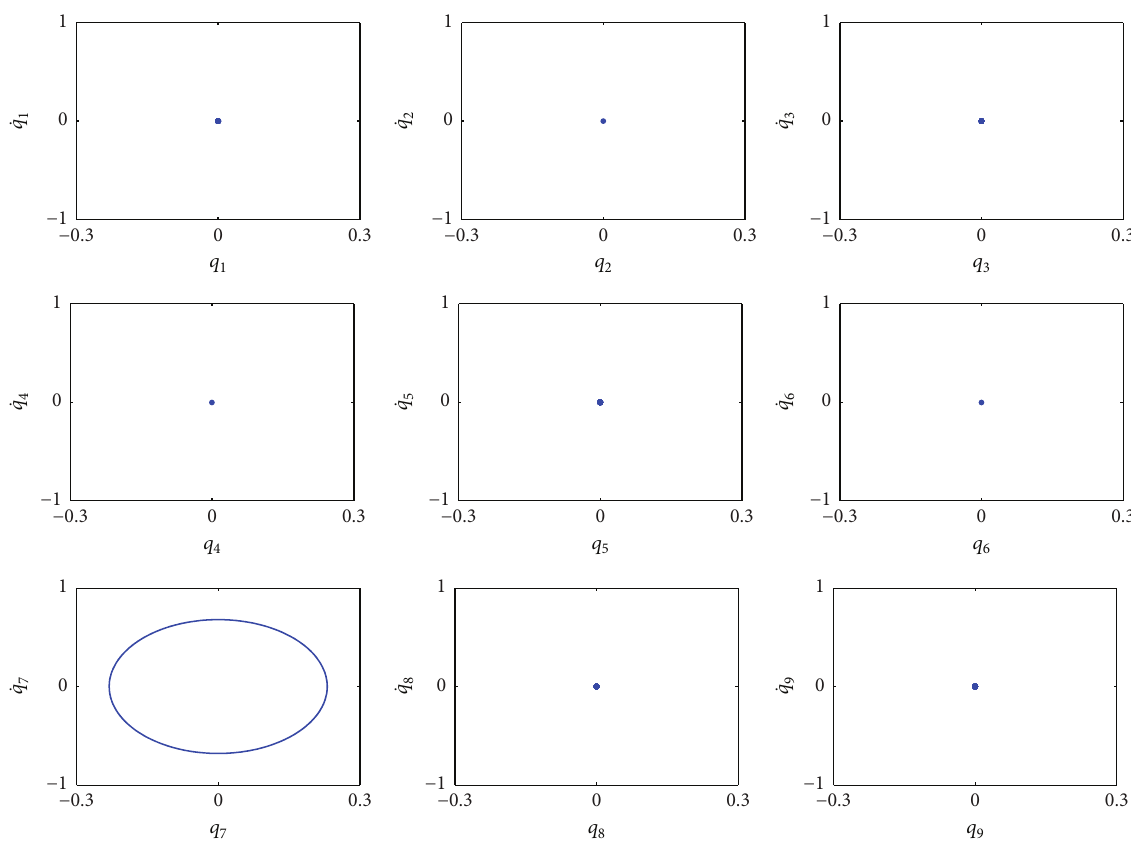
Figure 9: Two-dimensional projections of phase portraits onto the (𝑞 𝑟 , ̇𝑞 𝑟 ) plane, 𝑞 𝑟 (0) = 0.1𝛿 7𝑟 .